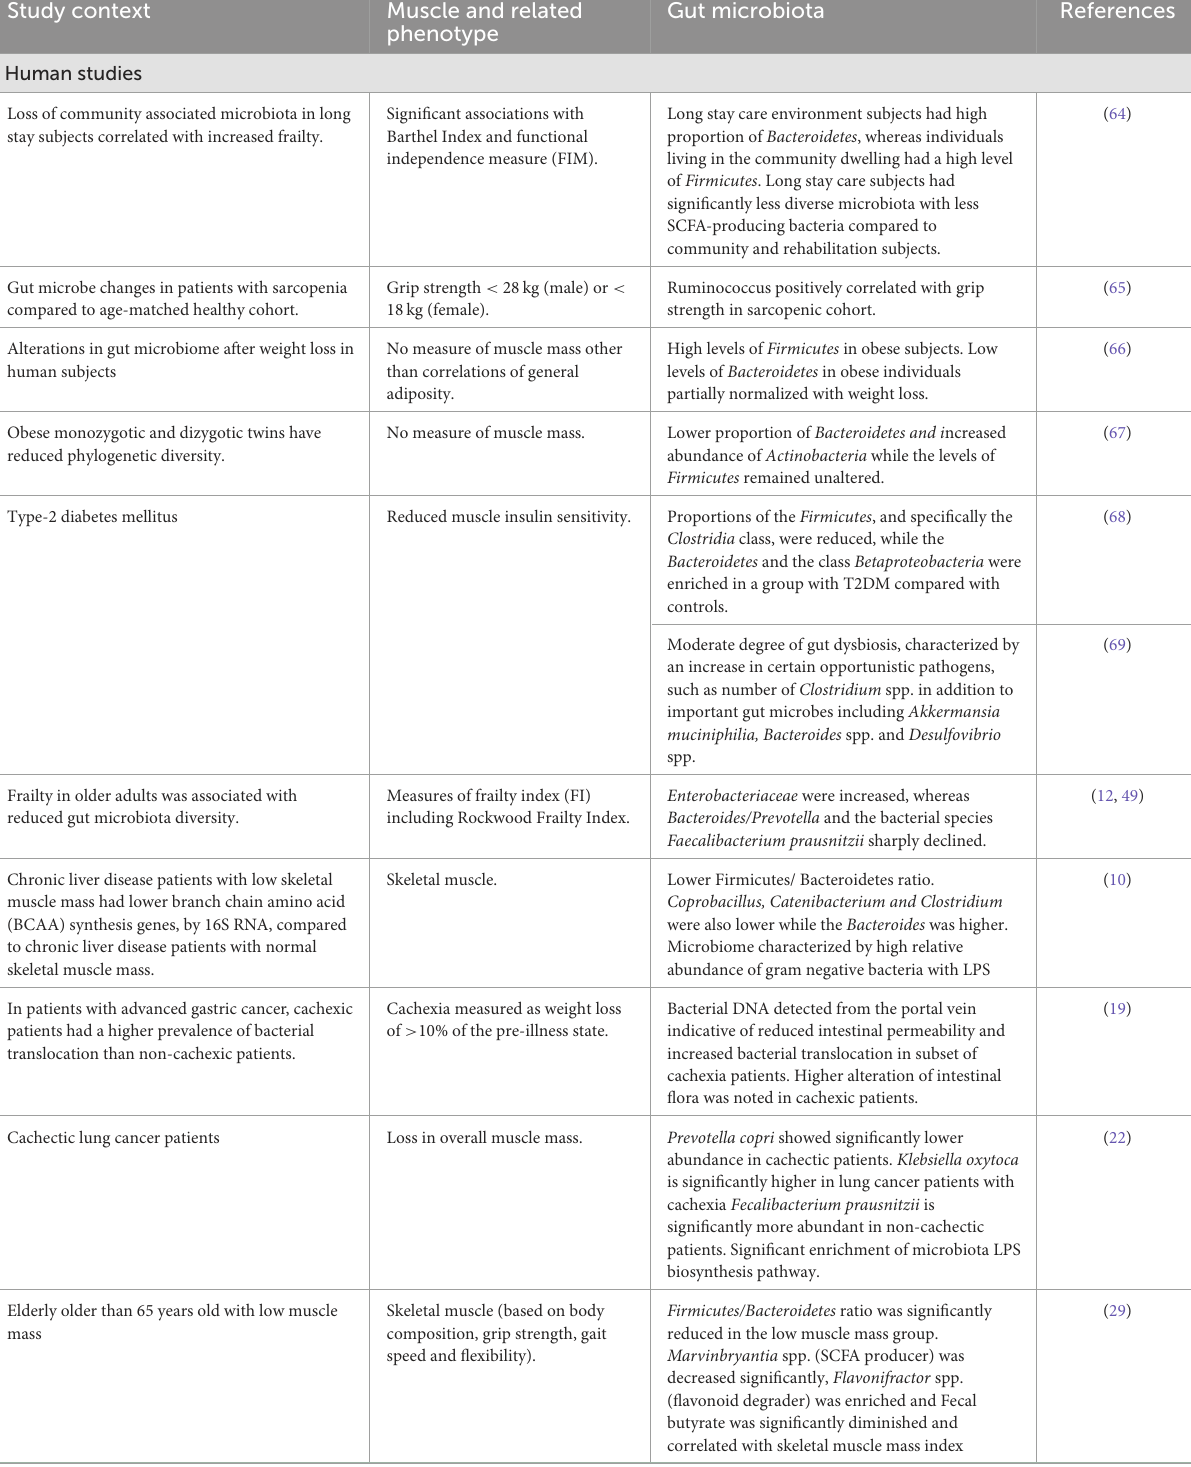
TABLE 1 List of human and animal studies that relate gut microbes to muscle and its related